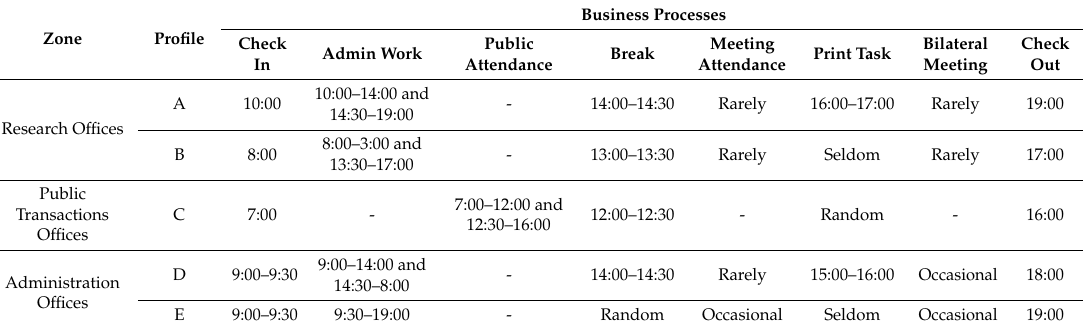
Table 8. Consumption per business process (Online Resource